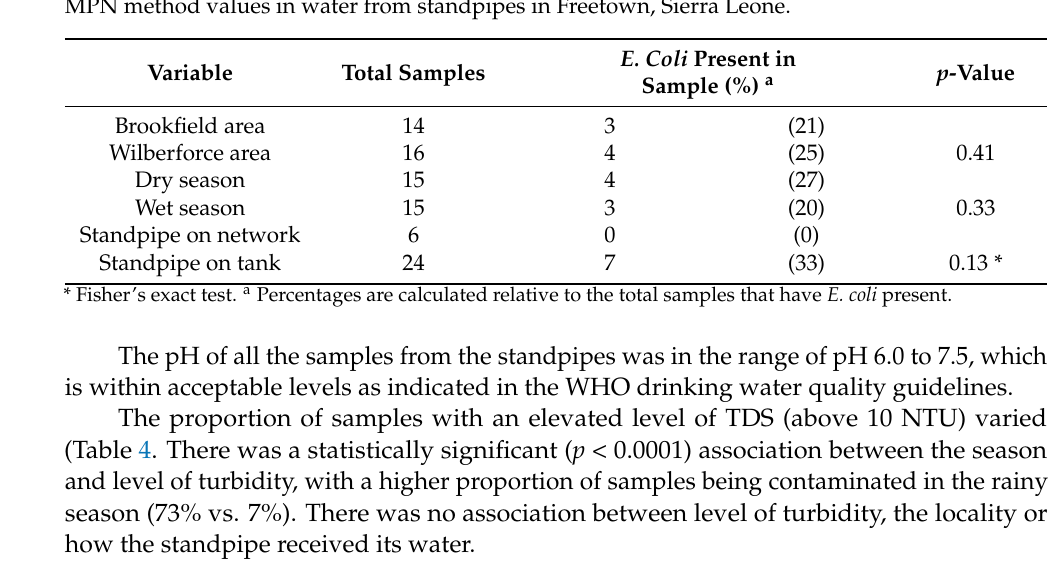
Table 4. Number of samples with the total dissolved solids above the recommended level in water from standpipes in Freetown, Sierra Leone.